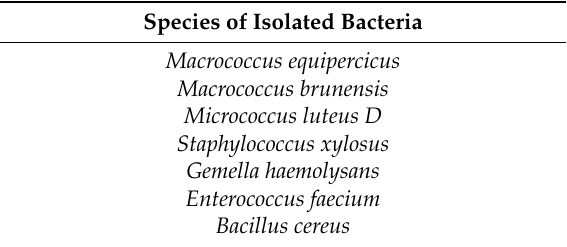
Table 6. Species of bacteria isolated from indoor office air.